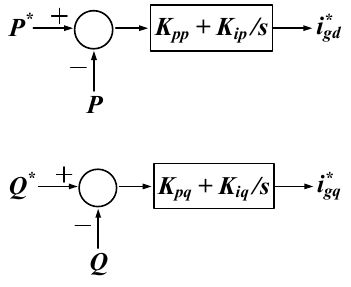
Figure 23. PI controller for power control.